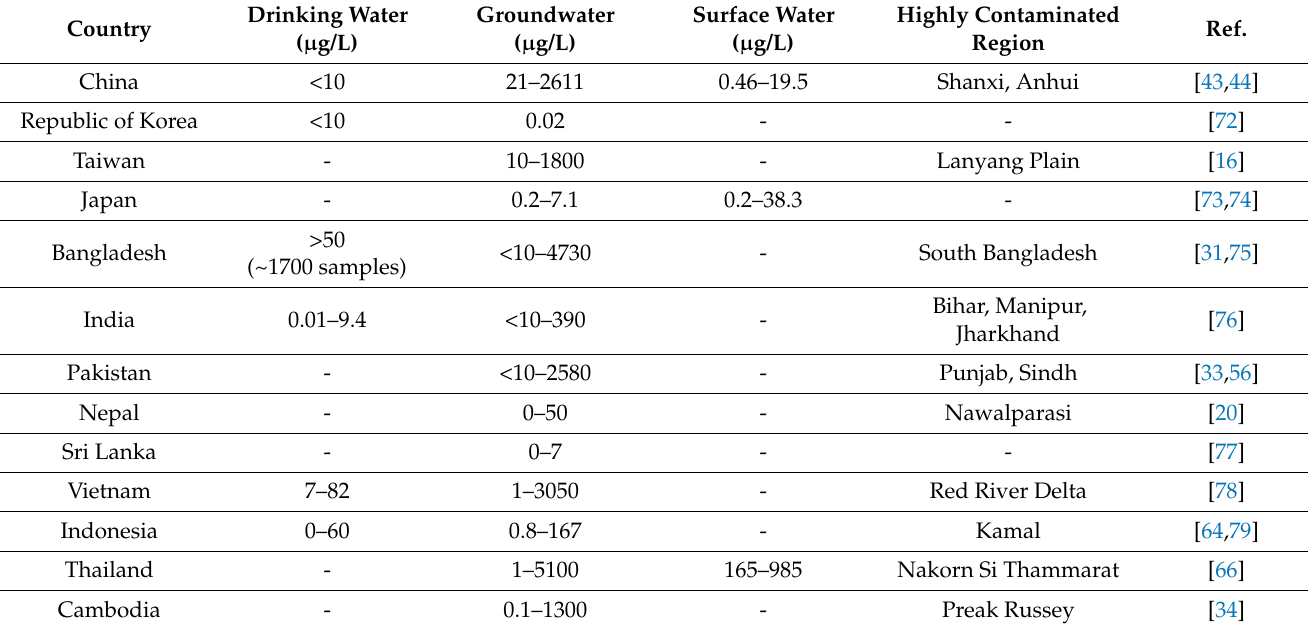
Table 1. Asian regions and concentration of arsenic in water (selected data from recent literature).